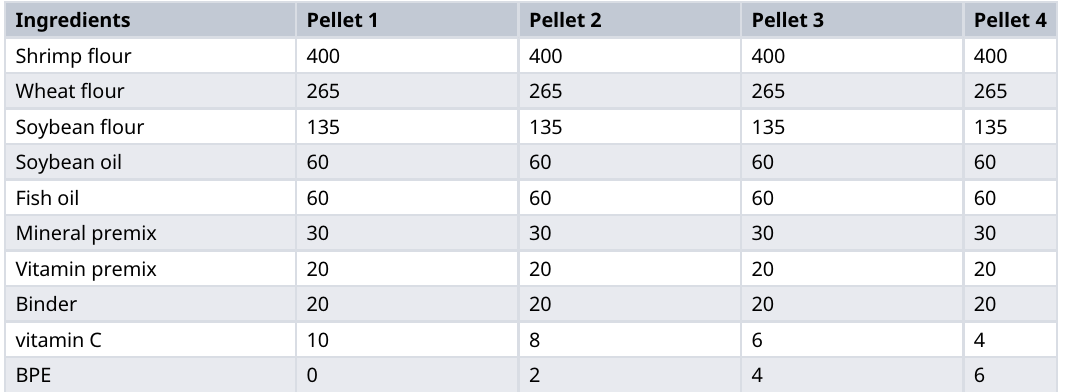
Table 1. Formulated composition of fish feed (g kg (cid:4) 1